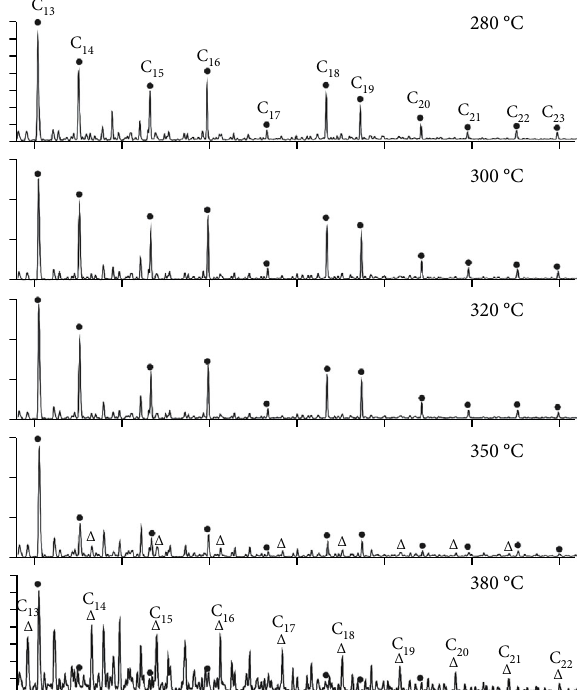
Figure 5: m/z 133+134 mass chromatograms of the aromatic fractions separated from asphaltene pyrolysates at di ff erent temperatures. Filled circles indicate AIPs, and un fi lled triangles indicate newly identi fi ed AAs. The mass chromatogram of the pyrolysates obtained at 260 ° C, which is almost the same as those at 280 ° C and 300 ° C, was not shown here.